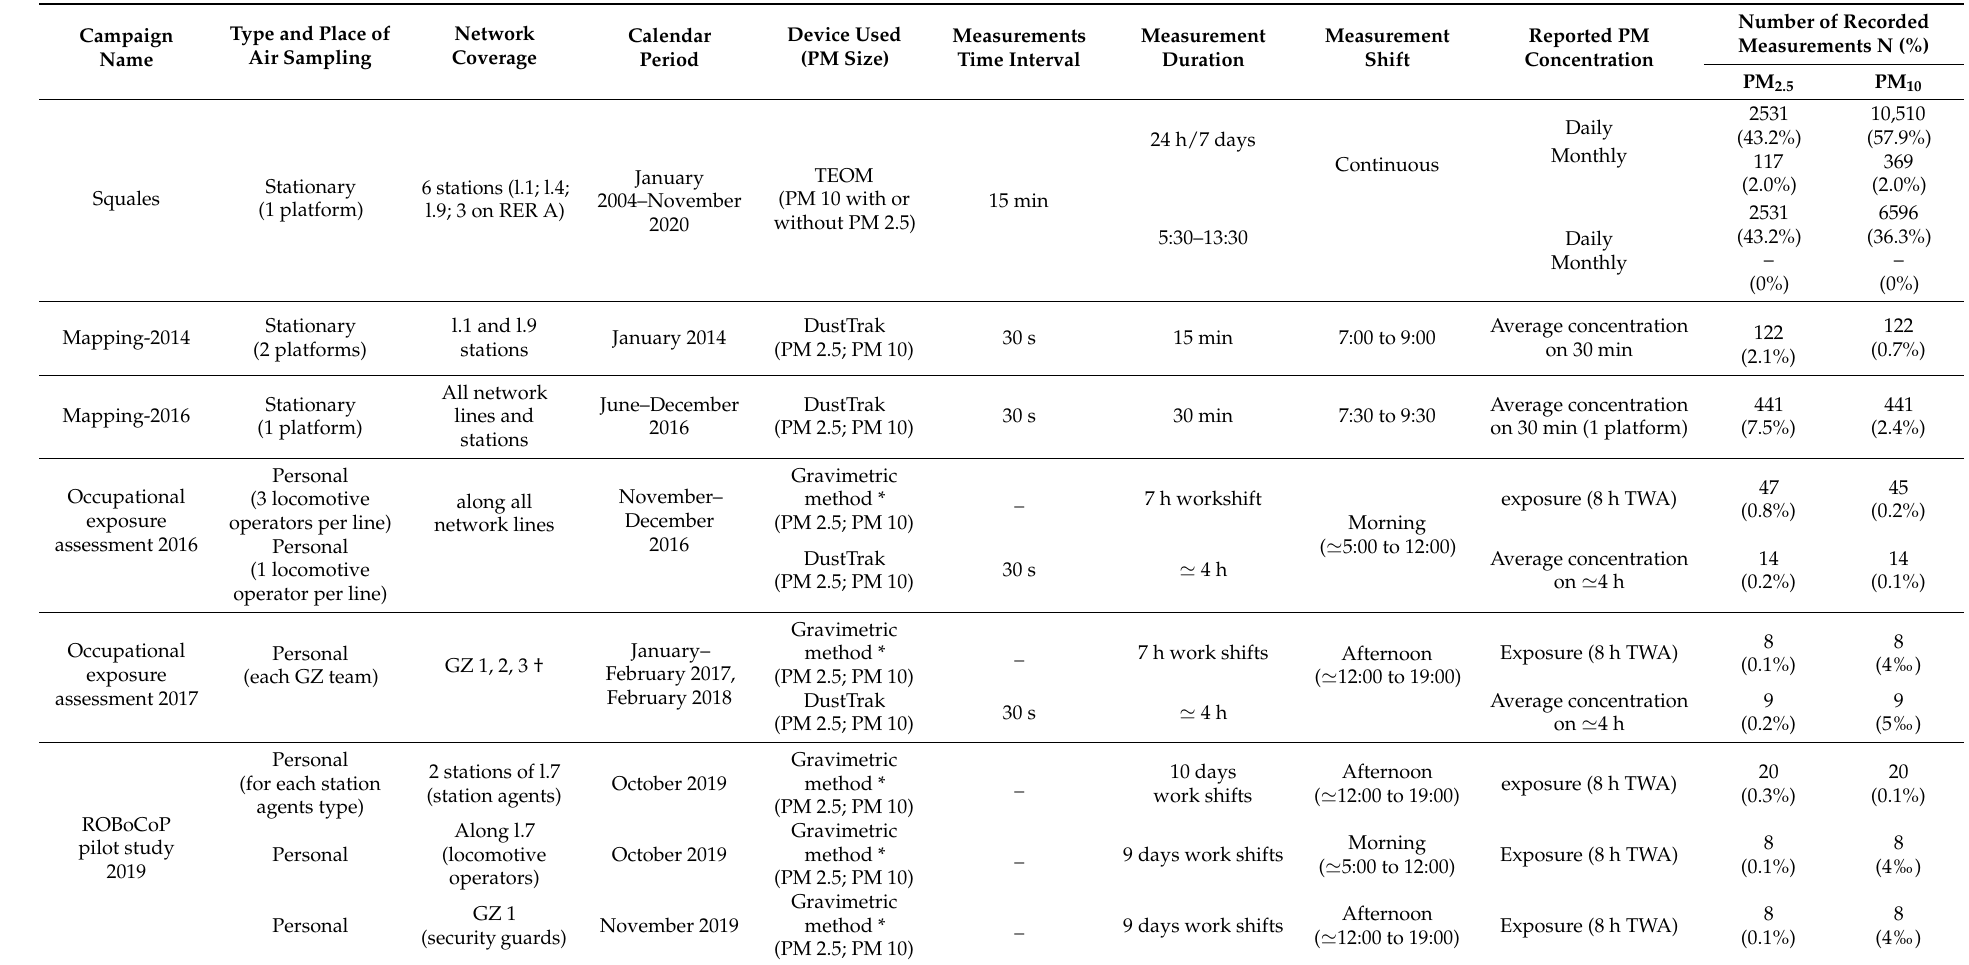
Table 2. Inventory of PM measurement campaigns conducted in the Parisian subway